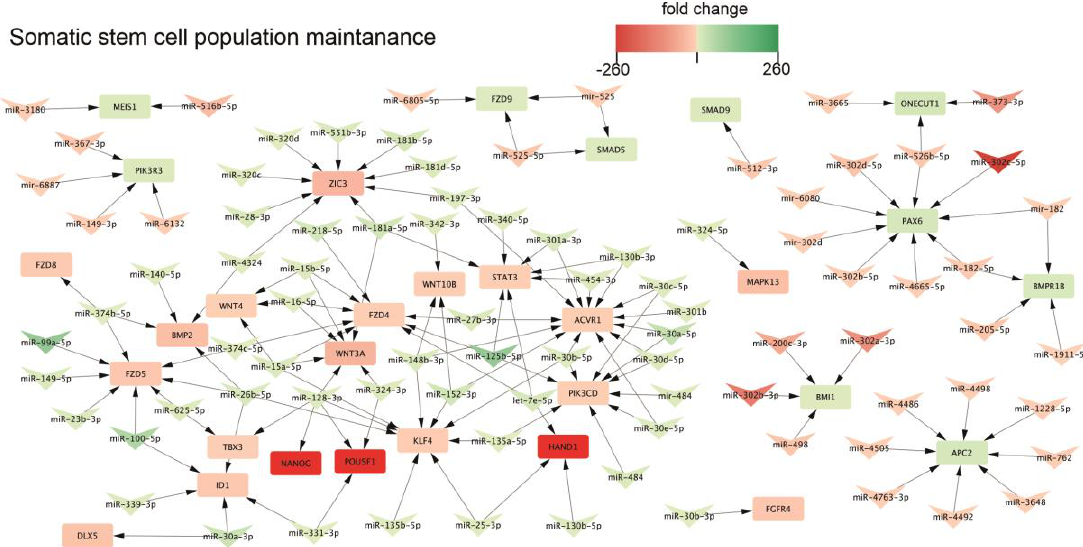
Figure 5. Signaling pathway regulating pluripotency of stem cells is modified during neural differentiation. Arrowheads represent differentially expressed miRNAs, and squares — negatively regulated genes.